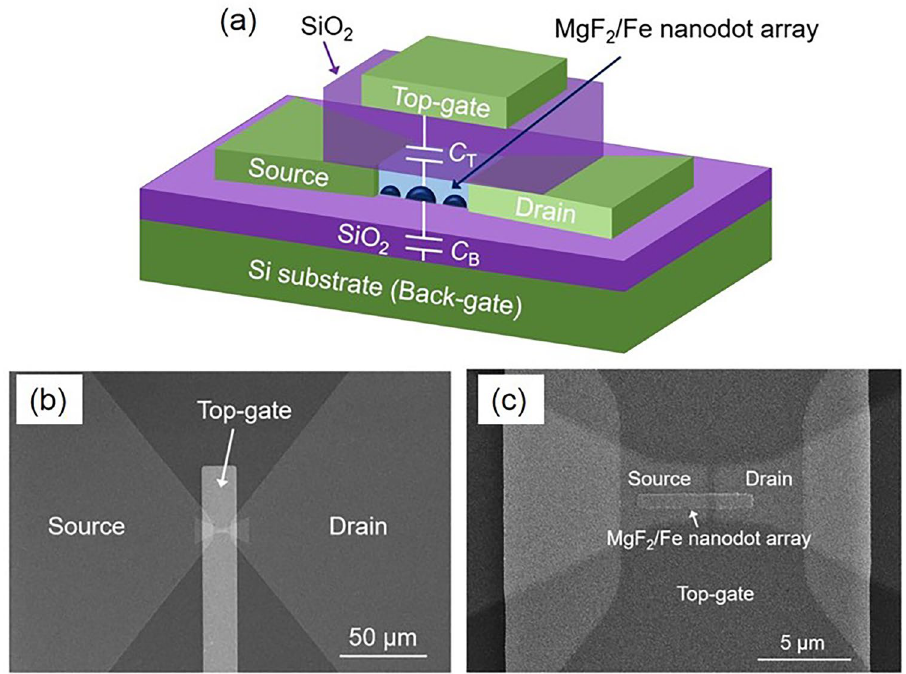
Figure 1. ( a ) Schematic and ( b ) and ( c ) scanning electron microscopy images (plan view) of the fabricated Fe nanodot array